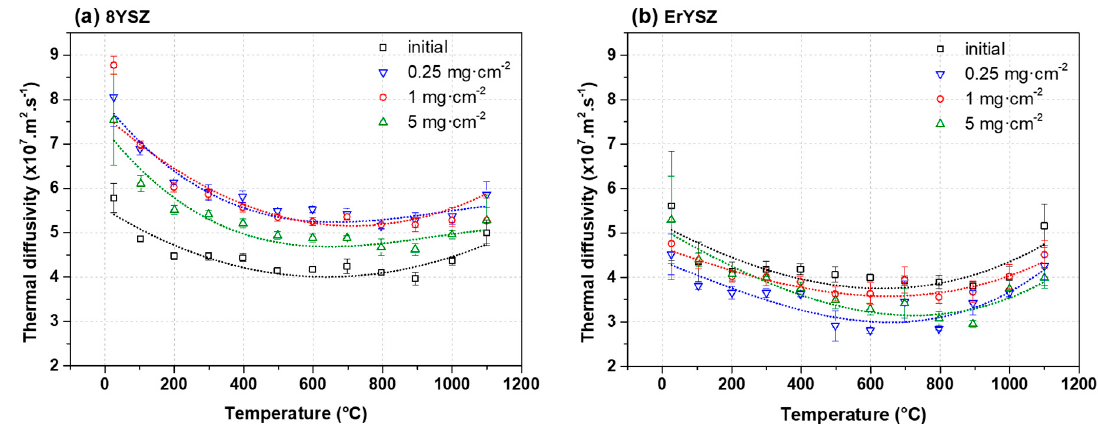
Figure 10. Thermal diffusivity of ( a ) 8YSZ standard and ( b ) ErYSZ thermal barrier coating (TBC) systems in the initial condition and after CMAS attack.